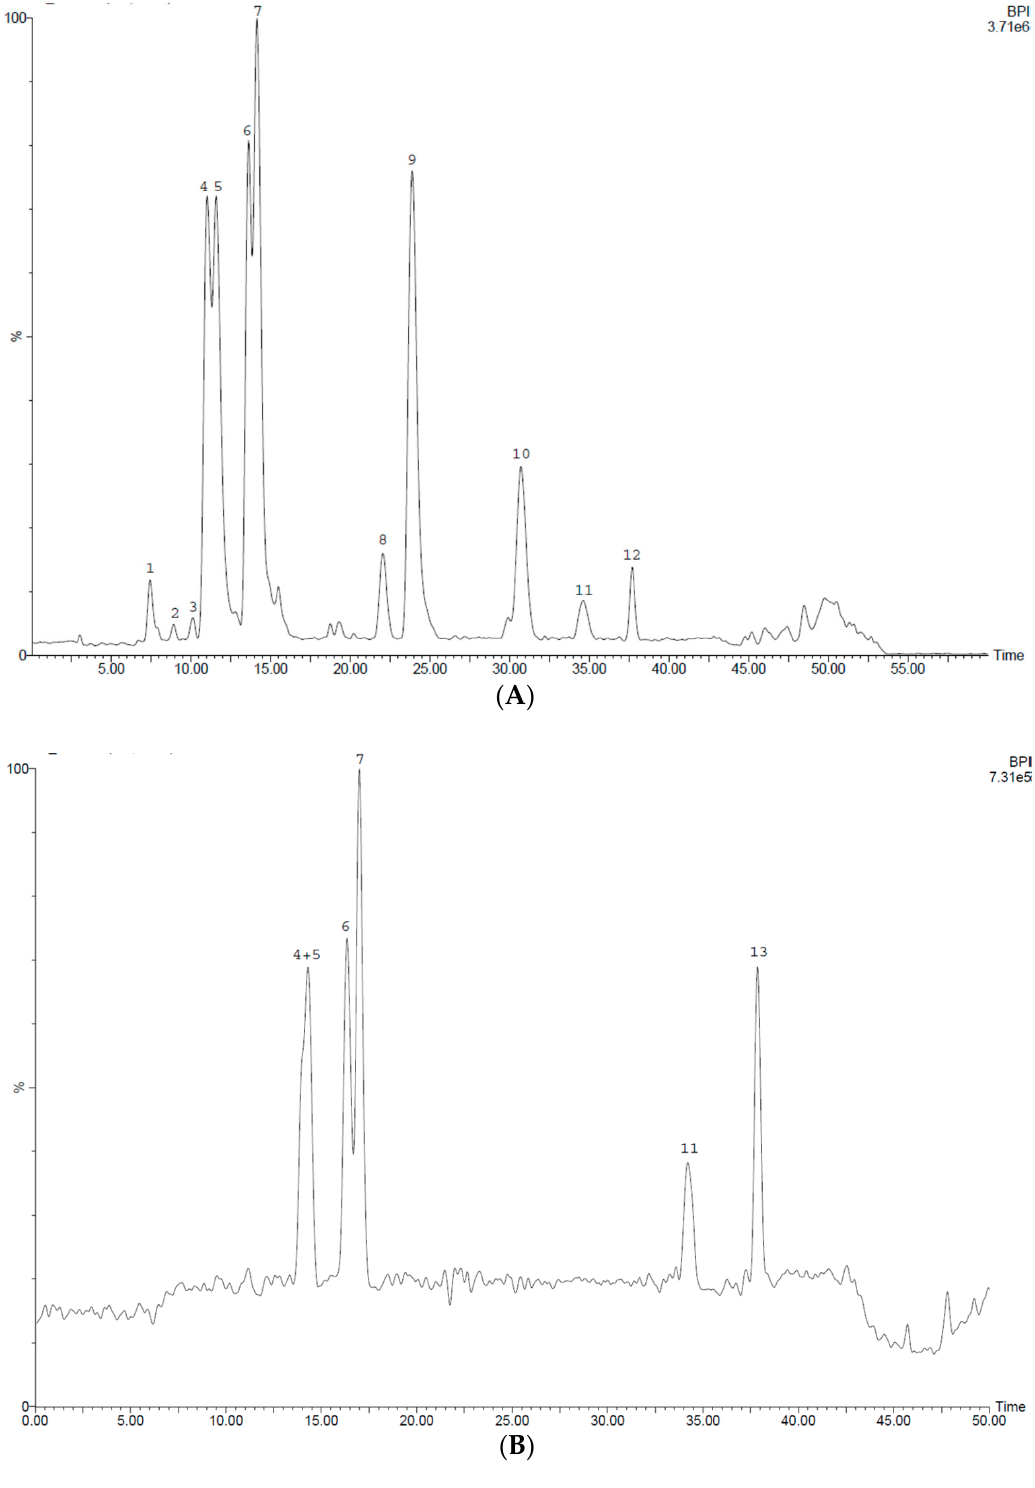
Figure 6. HPLC chromatograms of the extract samples obtained after sequential processing of the 70% ethanol extracts of fenugreek seeds with chloroform and ethyl acetate. ( A ) Seeds of FWV; ( B ) seeds of FSV. Table 5. Phenolic compounds analyzed by HPLC-ESI-MS in purified ethanol extracts of FWV and FSV seeds.